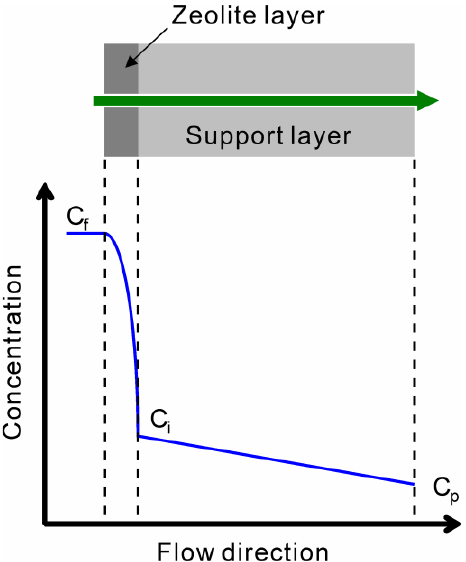
Figure 1. Schematic illustration of concentration gradient across the zeolite membrane supported by porous substrate. C f is the concentration in the feed, C p is the concentration in the permeate, and C i is the concentration at the interface of the zeolite and support layers.